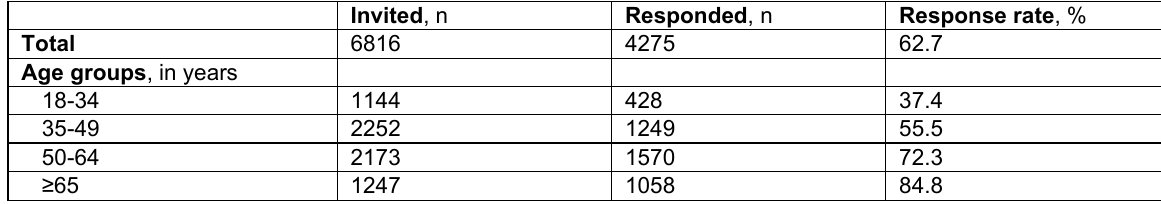
Supplementary table 1 . Response rates, overall and by age group in total